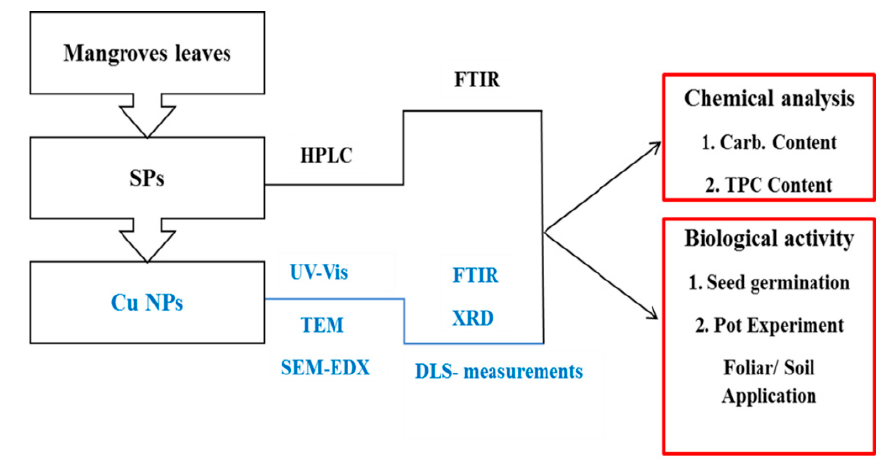
Figure 1. Schematic outline of the work conducted in this study.